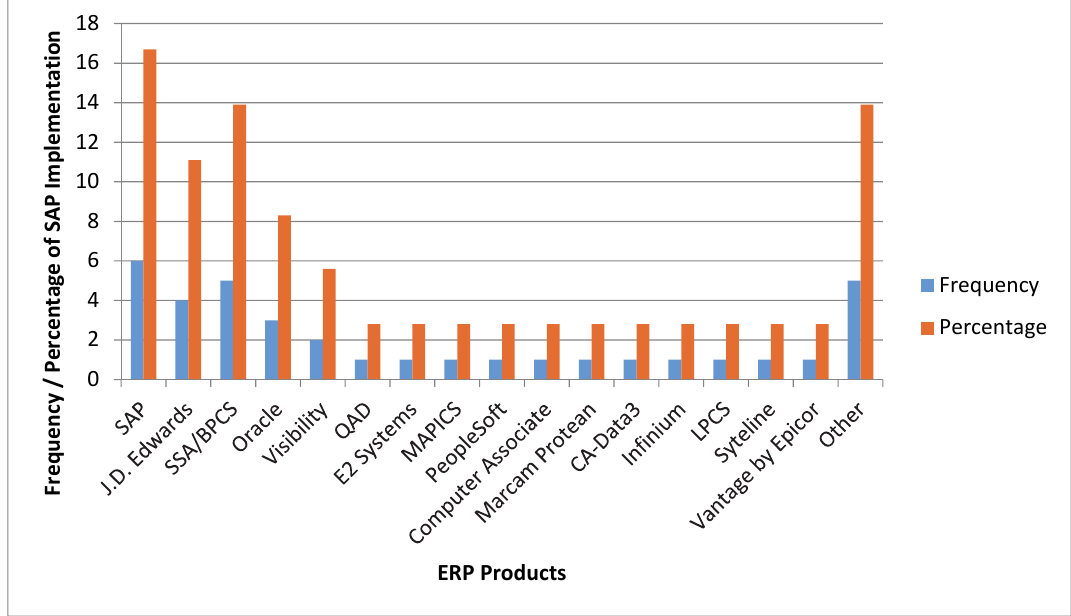
Fig. 1. ERP products and their